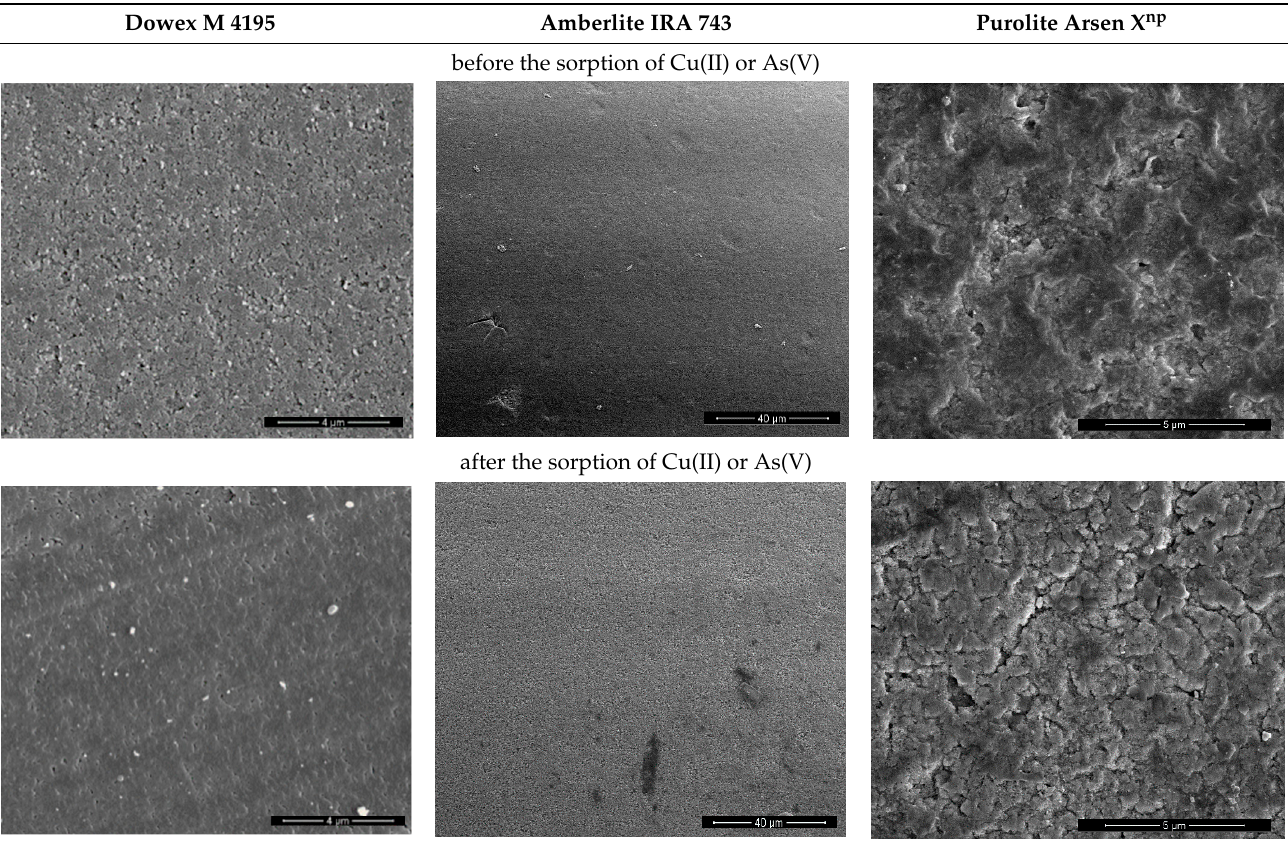
Table 2. SEM images of Dowex M 4195, Amberlite IRA 743 and Purolite Arsen X np . Dowex M 4195